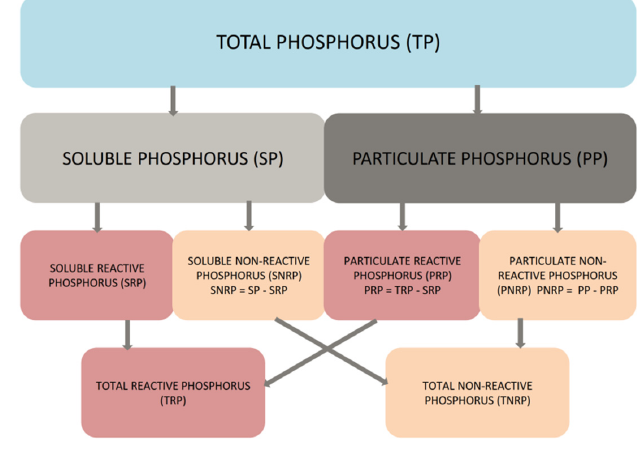
Figure 2. Scheme of phosphorus fractionation.